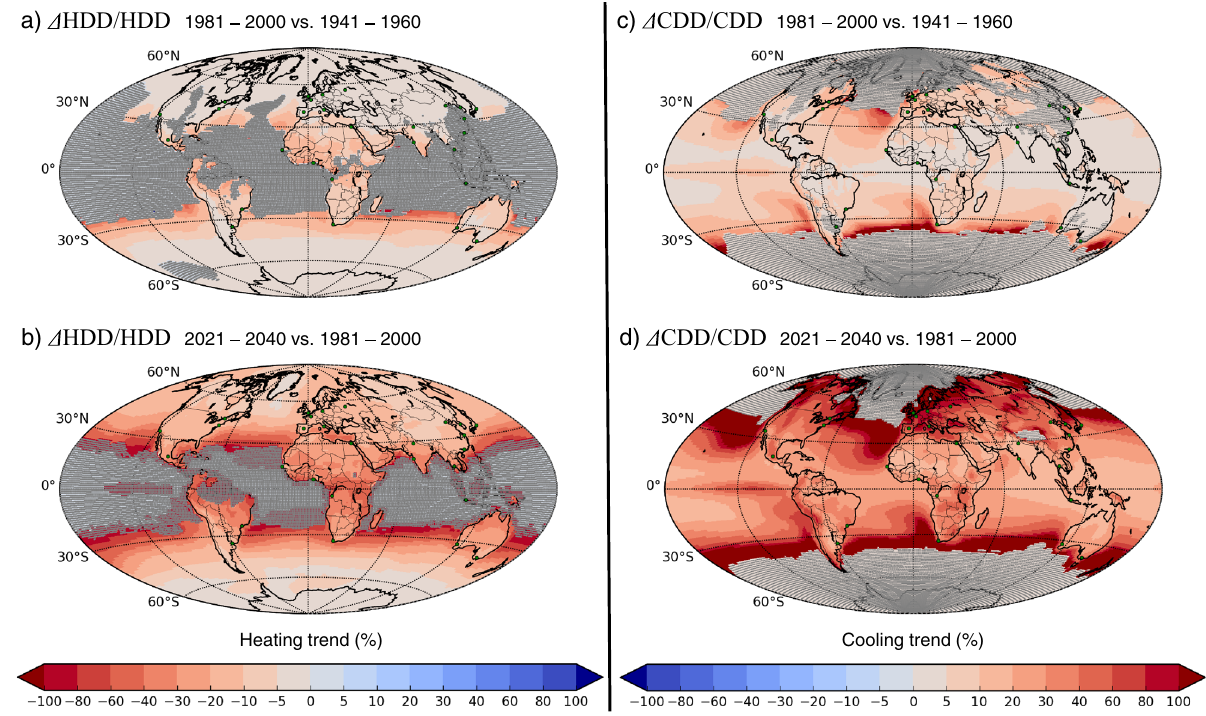
Fig. 2 Global climate-driven trends in energy demand for heating and cooling buildings. Trends are expressed in Heating Degree-Days ( Δ HDD/HDD) and Cooling Degree-Days ( Δ CDD/CDD) between the periods ( a, c ) 1981 – 2000 and 1941 – 1960, and ( b, d ) 2021 – 2040 and 1981 – 2000. Multi-model means of annual HDD and CDD sums were calculated using the daily mean, minimum and maximum temperatures from 30 CMIP5 simulations, and averaged over the 20-year periods. Differences are given in % compared to the earlier period. The areas shaded in gray indicate locations where the difference is not signi fi cantly different from zero according to Student t test at a 95% con fi dence interval. Projections are based on the RCP8.5 scenario. Note that the color scale in ( a and b ) is inverted compared ( c and d ), so that in all panels red colors correspond to changes caused by increasing temperatures. Green dots denote the location of the cities in Fig. 3 of the main text and Supplementary Table